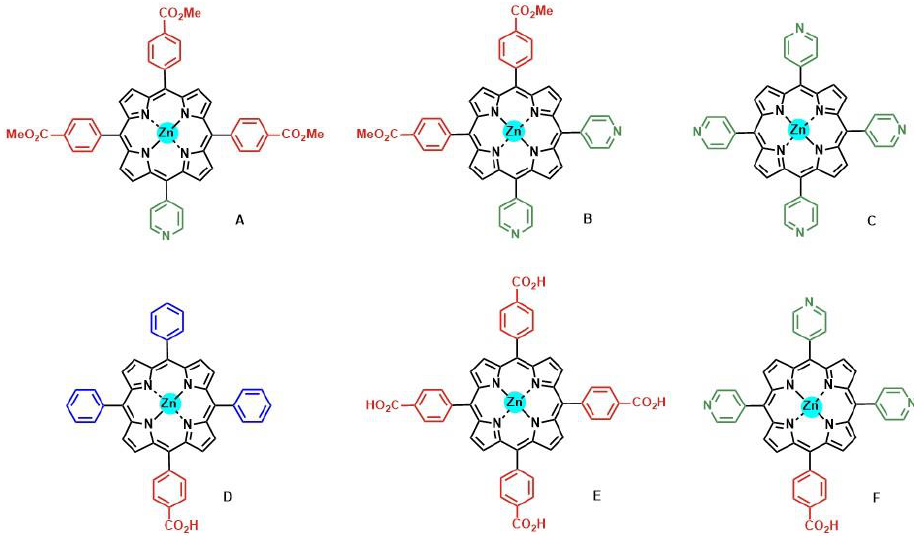
Figure 12. Molecular structures of the series of Zn porphyrin dyes reported by Daphnomili et al. ( A – C ) [66] and Calmeiro et al. ( C – F ) [64].